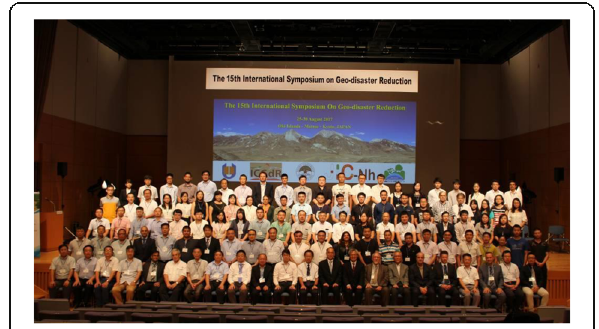
Fig. 4 Group photo of participants of the 15th ISGdR in Terrsa